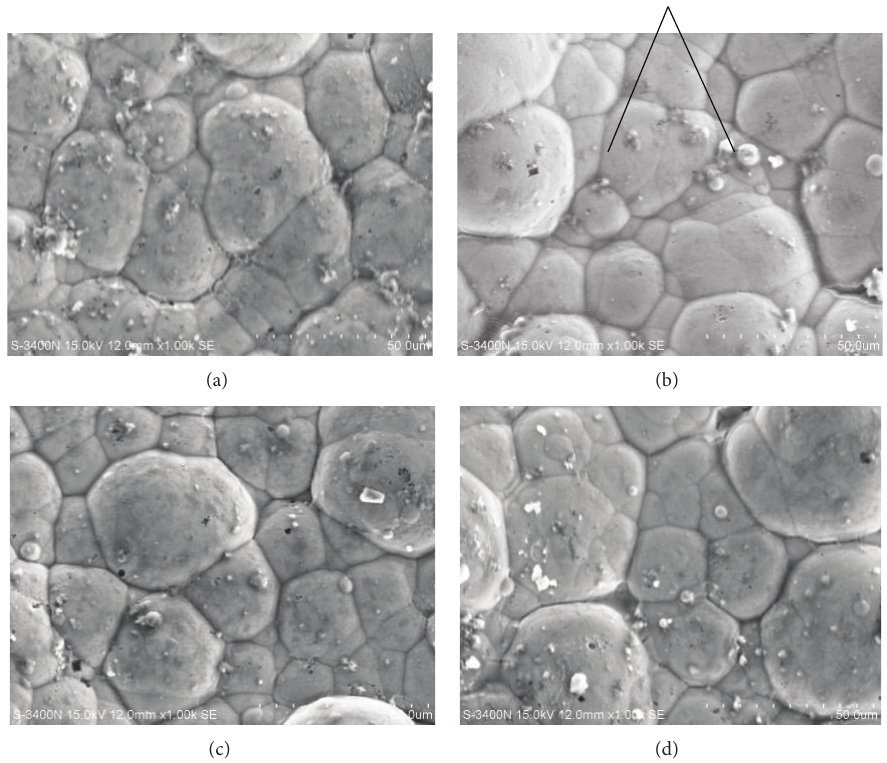
Figure 8: SEM micrograph (1000 × ) of electroless Ni–P coated with SLS surfactant on magnesium (Mg) composite reinforced with multiwall carbon nanotube (MWCNT) at various ZnO concentrations: (a) 0.1%, (b) 0.5%, (c) 1%, and (d) 2%.